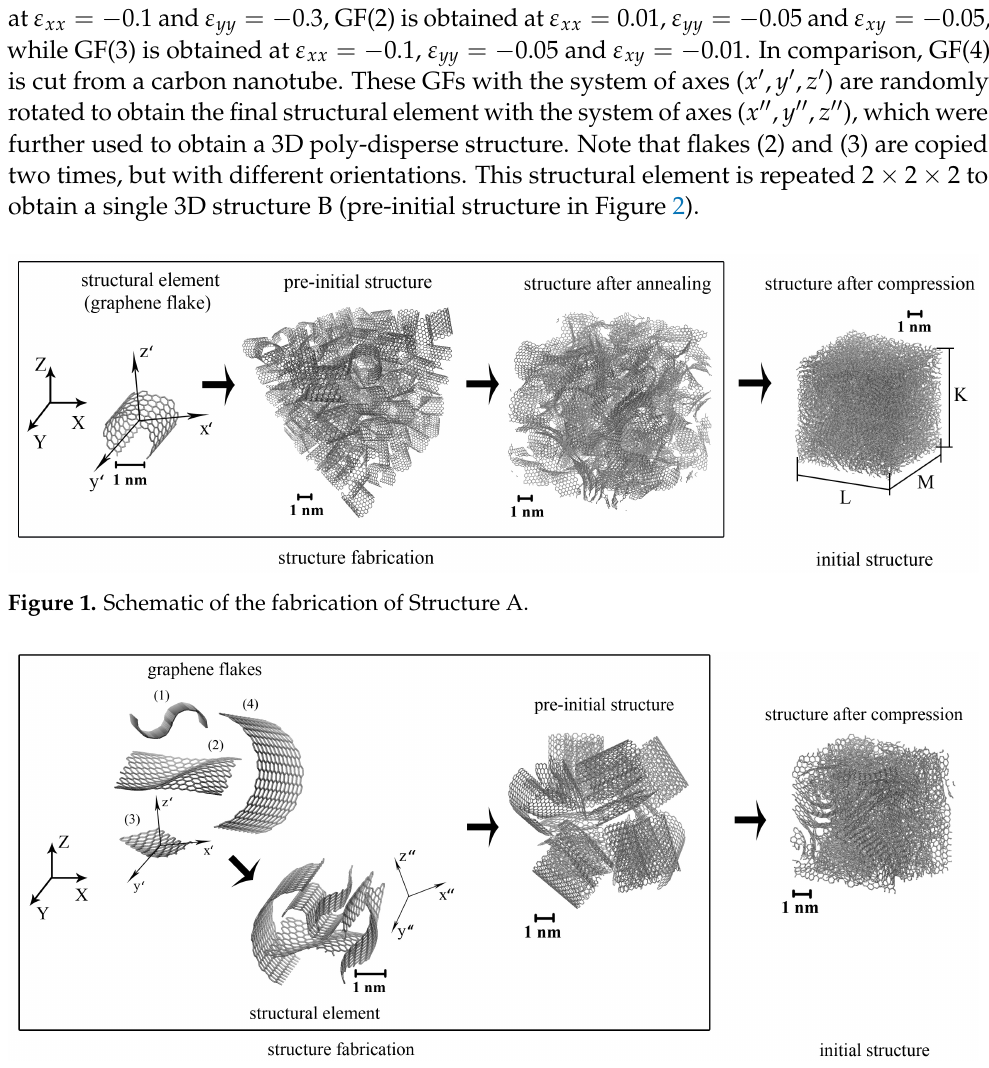
Figure 2. Schematic of the fabrication of Structure